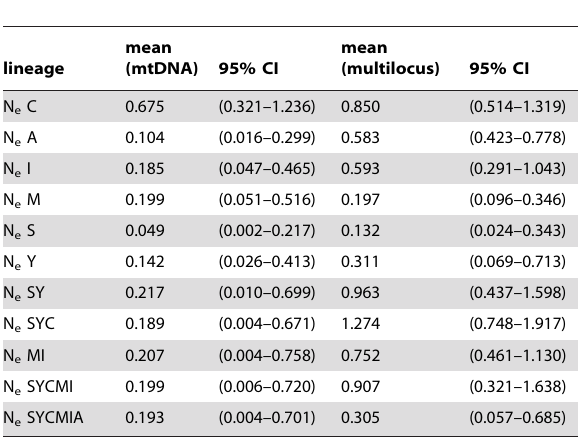
Table 2. Effective population sizes of extant and ancestral